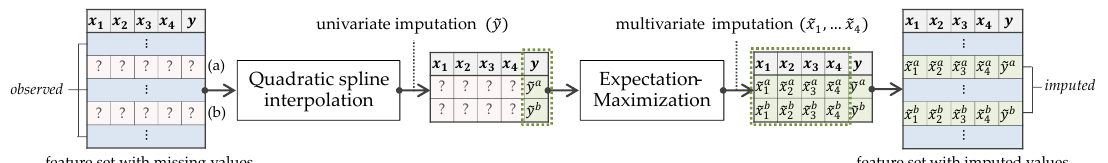
Figure 8. Imputation approach.